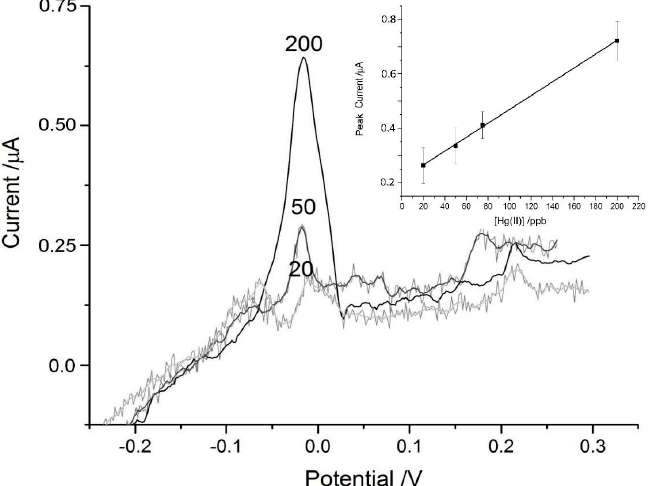
Figure 7. Representative ASV scans for MT-loaded discs with 25 μ L drops of diluted Hg 2+ standards with concentrations of 20, 50 and 200 ppb. The concentration is indicated on the graph near the Hg 2+ peaks around − 0.02 V. The peaks near +0.2 V correspond to the thiols of metallothionein. Inset in the top right corner is the linear fit of the data ( n = 3).